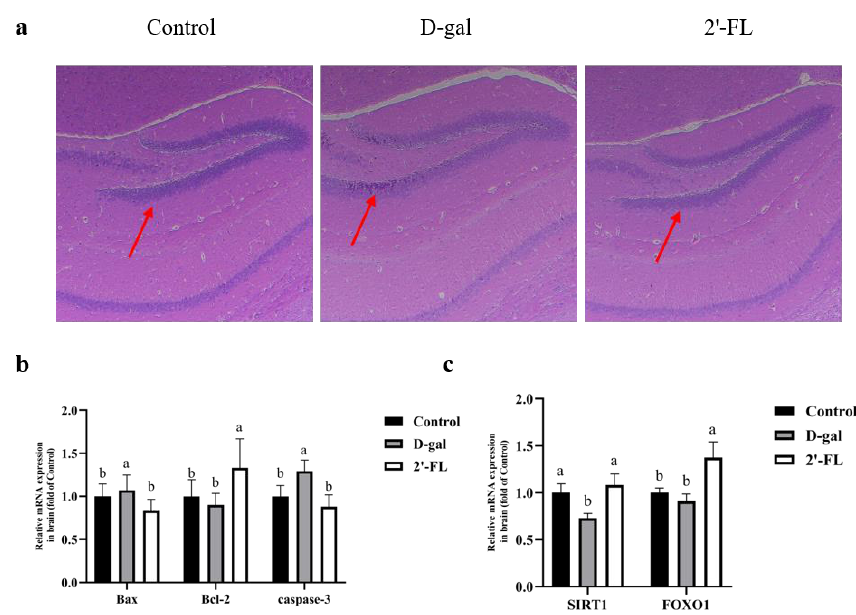
Figure 6. Effects of 2′− FL on inflammation, longevity, and apoptosis in the brain. ( a ) H&E staining of the hippocampus (zoom in 100×; arrows indicate inflammatory infiltration). ( b ) Expression of apoptosis at the gene level. ( c ) Expression of the SIRT1/FOXO1 pathway at the gene level. Letters a and b indicated significant differences between groups ( p < 0.05).